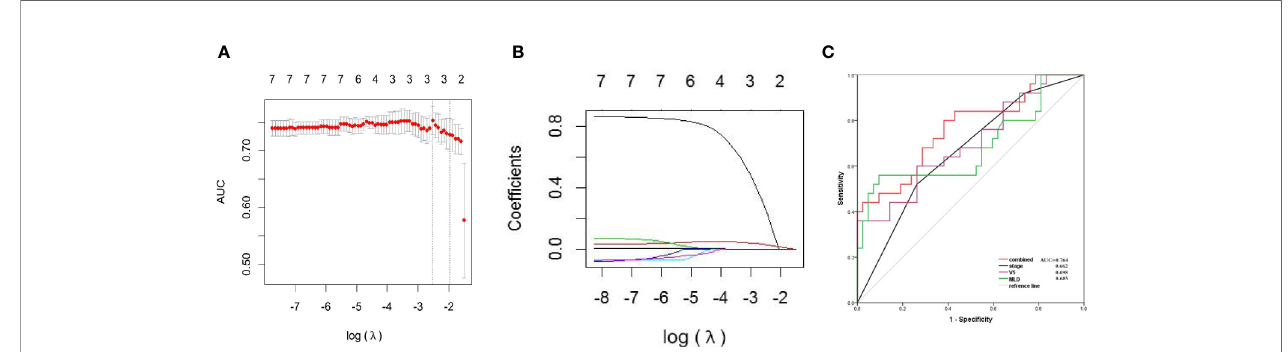
FIGURE 2 | LASSO characteristic selection of clinical features and dosimetric parameters (A, B) . ROC curve of V5, MLD, tumor stage, and combined model (C) .